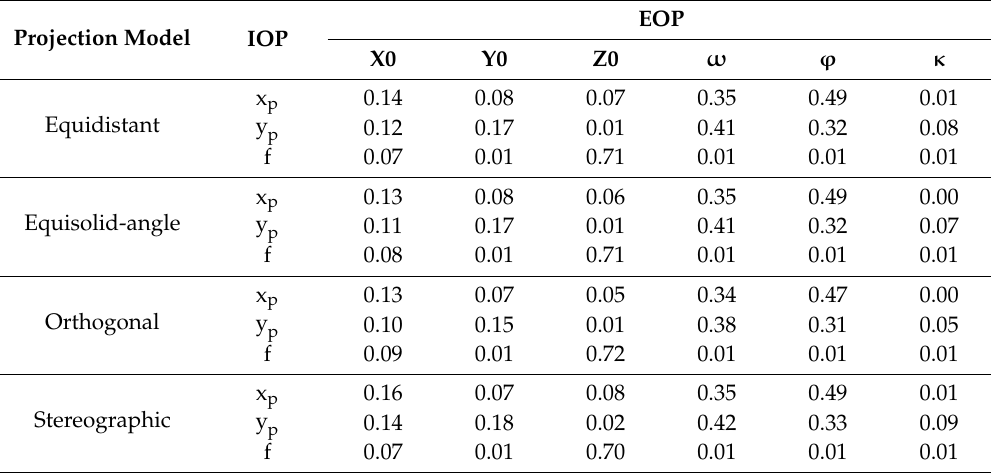
Table 17. Correlation between the orientation parameters (image-set